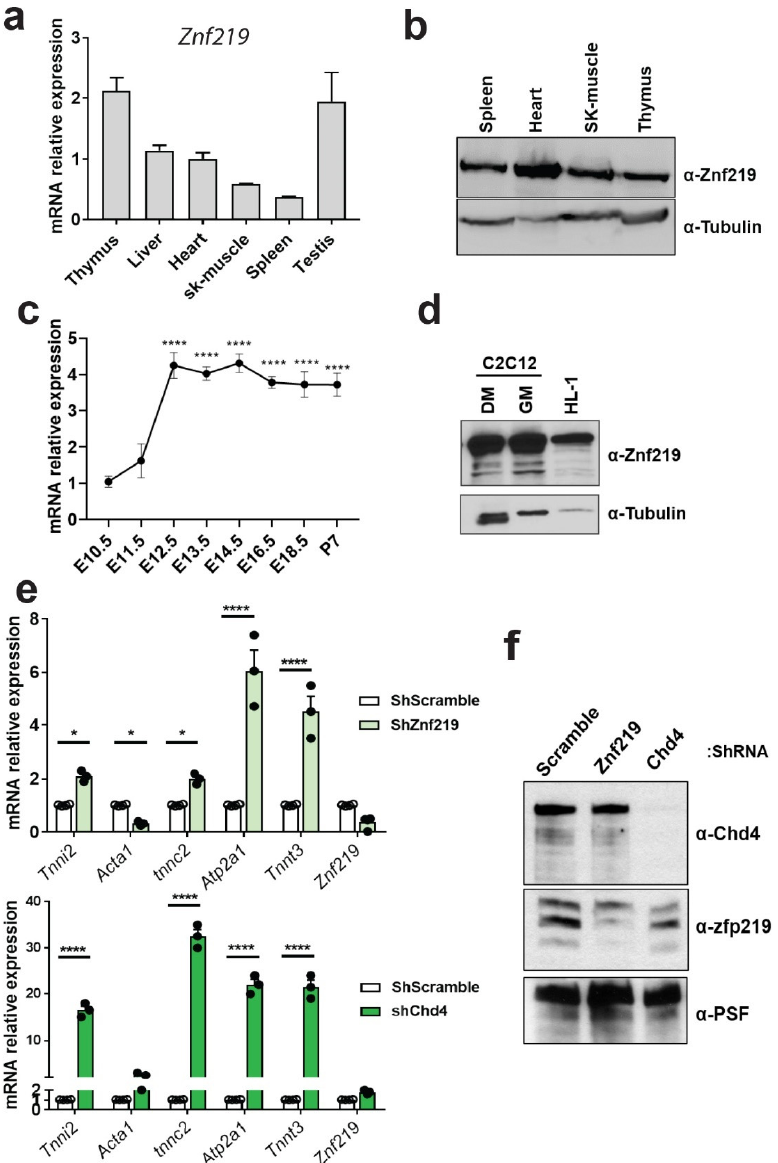
Figure 2. Znf219 represses the skeletal-muscle sarcomeric program in vitro. ( a ) Relative mRNA expression of Znf219 in different mouse organs (n = 4). Sk-muscle = skeletal muscle (tibialis anterior). ( b ) Western blot of different mouse organs, showing predominant Znf219 protein expression in the heart. ( c ) Relative mRNA expression of Znf219 during mouse cardiac development (n = 3). ( d ) Western blot of skeletal and cardiac cell lines, showing Znf219 protein expression in myocytic cell line C2C12 and the cardiomyocytic cell line HL-1. DM = differentiation media; GM = growth media. ( e ) qPCR analysis of representative skeletal muscle genes in HL-1 cells silenced for Znf219 or Chd4 with corresponding shRNAs. Cells infected with scrambled shRNA were used as a control (n = 4); two-way ANOVA (Bonferroni); * adj- p -value <0.05, **** p -value <0.0001. ( f ) Western blot showing the extent of knockdown of Znf219 (lane 2, middle) and Chd4 (lane 3, up) with the corresponding shRNAs. Lane 1 corresponds to HL-1 cells infected with scrambled shRNA (Scramble).